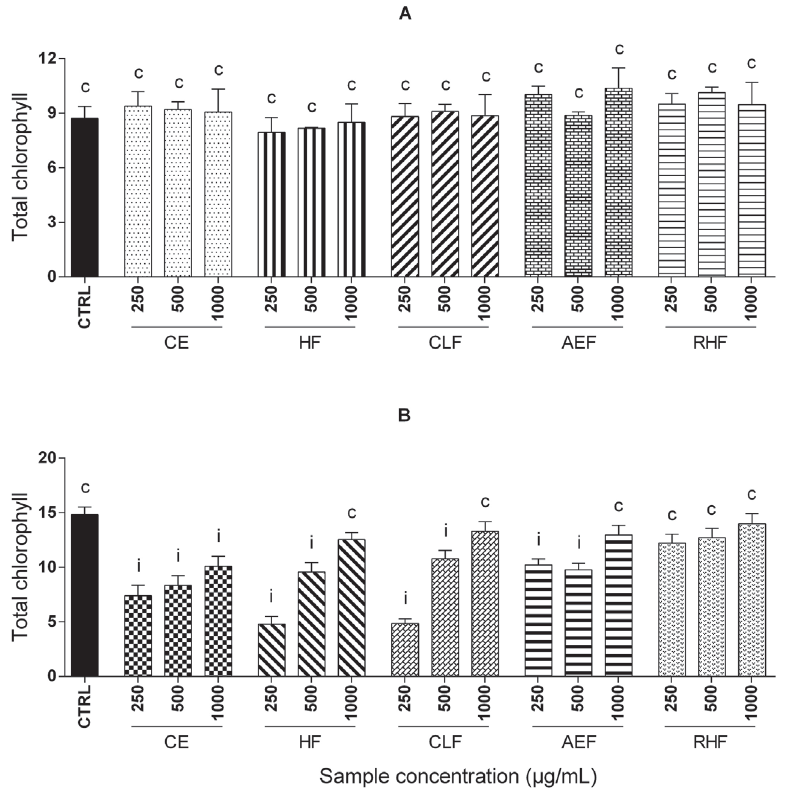
FIGURE 4 - Photosynthesis of L. sativa (A) and A. cepa (B). Treatment means differ significantly (p< 0.05) when compared to control means i inhibiting or e stimulating photosynthesis by Scott-Knott test. Treatment means do not differ significantly from c control